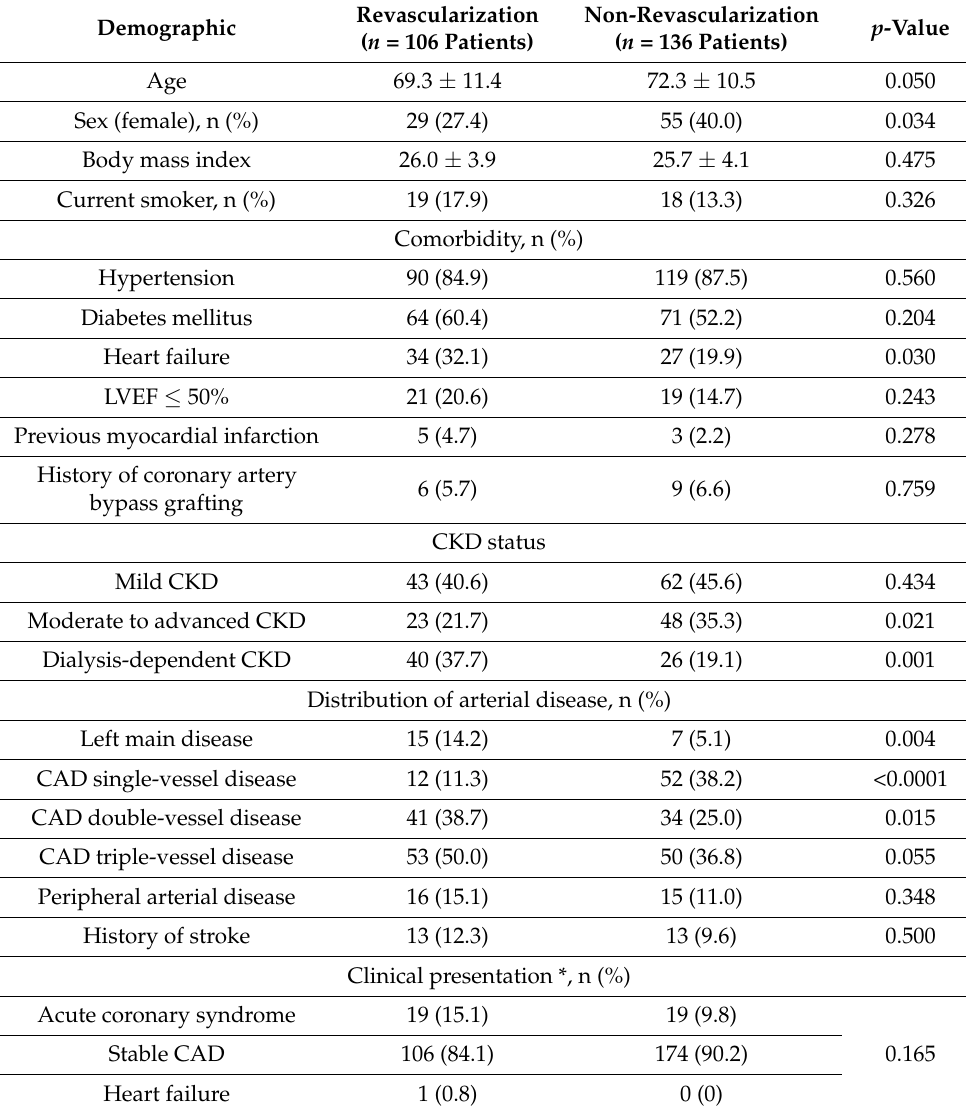
Table 1. Baseline and target vessel characteristics of patients with CKD who received FFR examination at NTUH, stratified by FFR ≤ 0.8 (revascularization) and FFR > 0.8